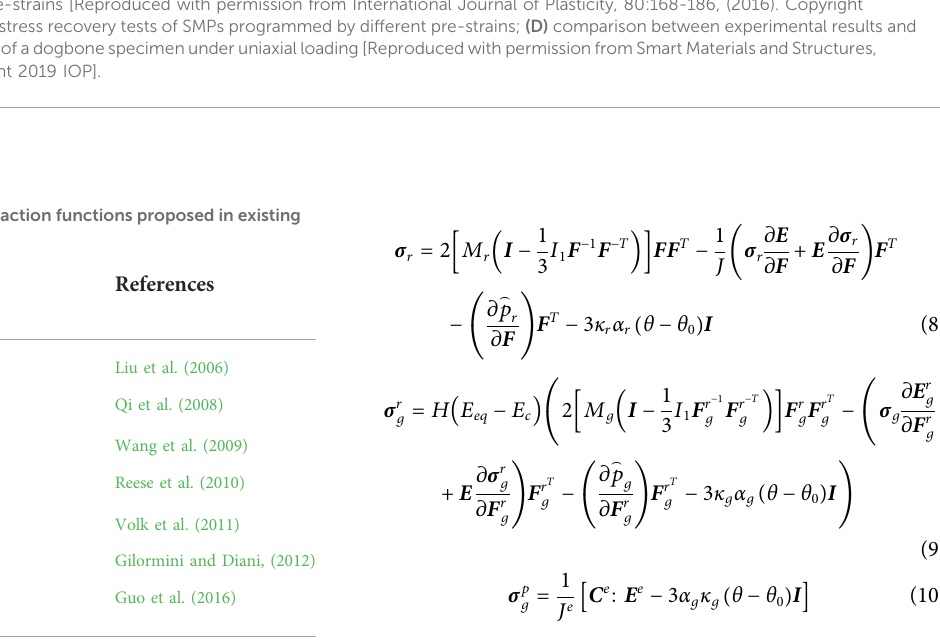
inwhich J e , C e , and κ g arethe Jacobin forthe elastic part, theisotropic elasticity tensor, and the bulk modulus for the glassy phase, respectively. M r and M g are two functions with respect to